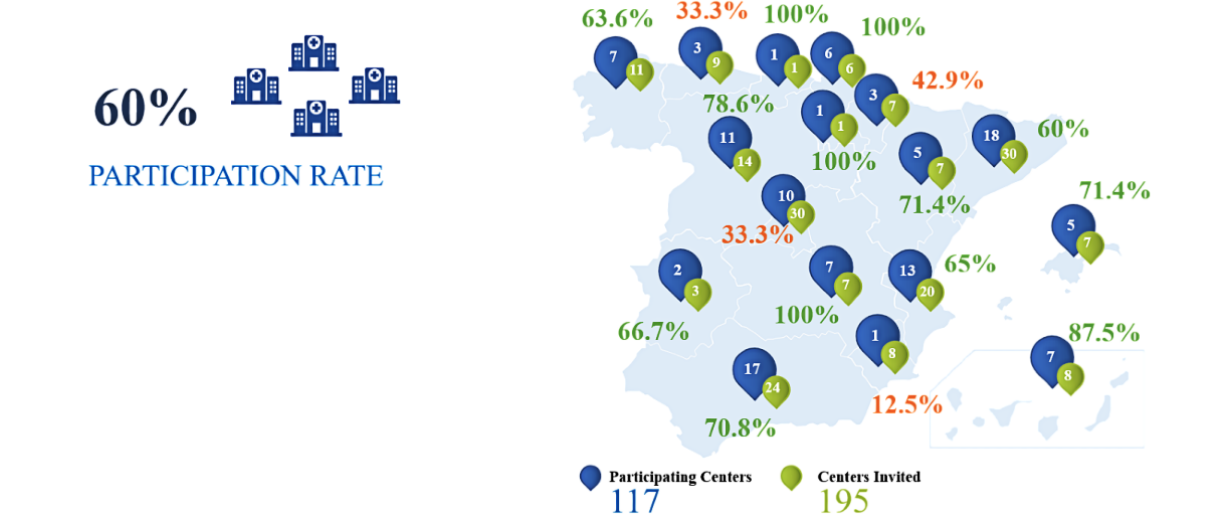
Figure 1. Distribution of the contacted acute inpatient psychiatric units (AIPUs) and participation rates per